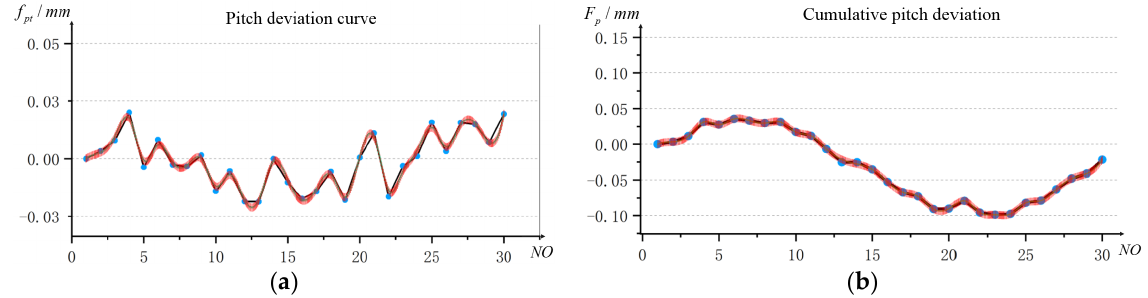
Figure 15. The fitted curve of the pitch deviation, ( a ) tooth pitch deviation curve on the individual teeth, and ( b ) the cumulative pitch deviation curve.